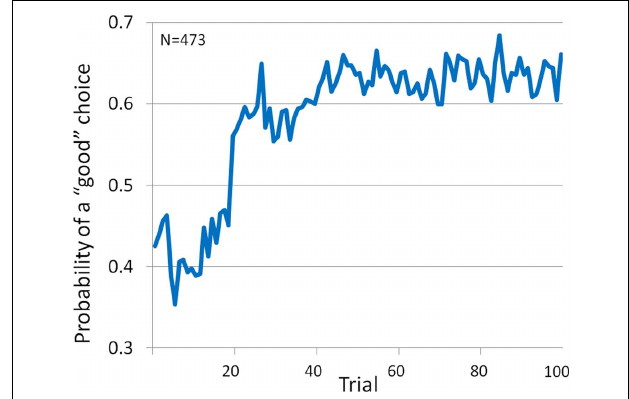
FIGURE 3 | Mean net score [(C (cid:2) + D (cid:2) ) − (A (cid:2) + B (cid:2) )] for groups defined by reported experience of childhood (ages 0–12) trauma across five blocks of 20